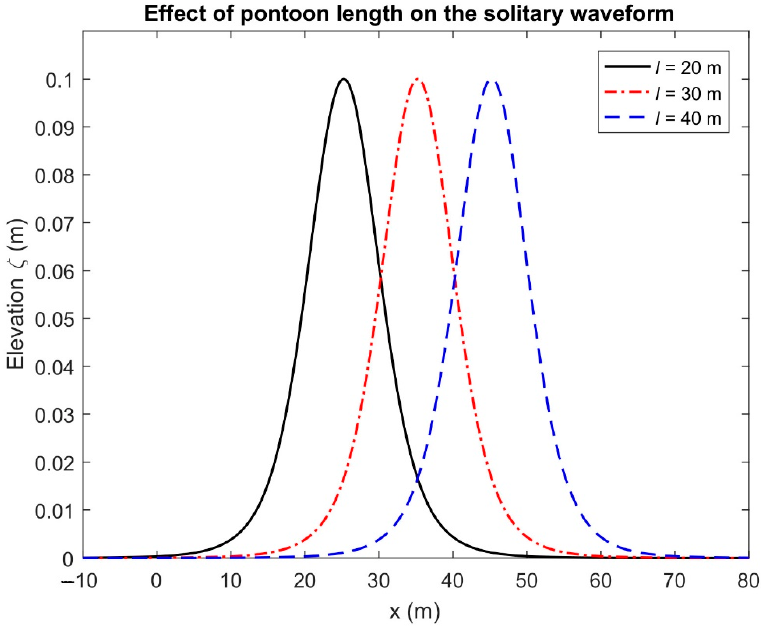
Figure 19. Effect of pontoon length on the solitary wave profiles in the outer region versus water plane length x (m).